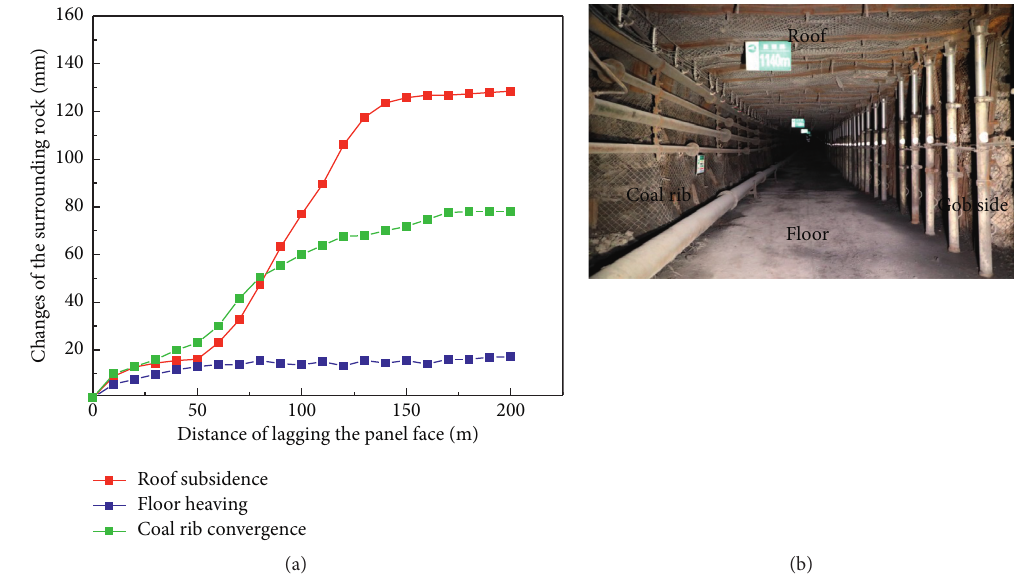
Figure 16: Surrounding rock control effect. (a) Changes of the surrounding rock. (b) Photo of retained gob-side